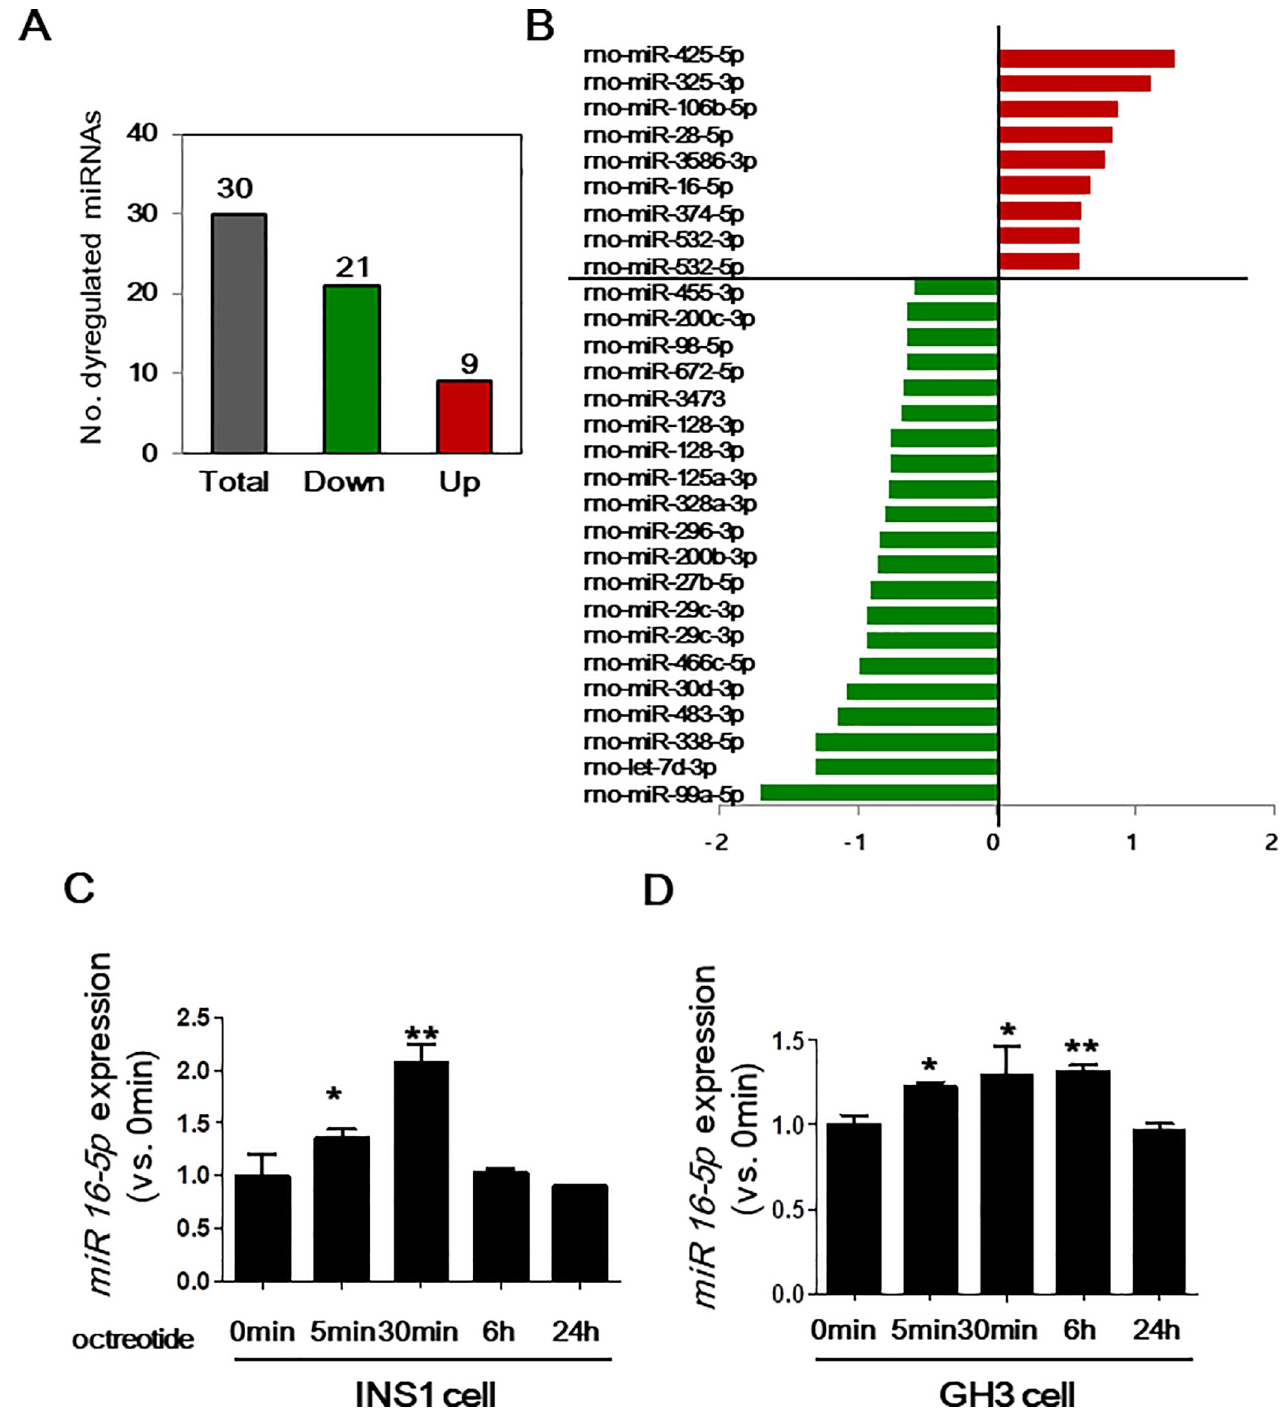
Fig 2. Microarray analysis of miRNA expression. miRNA profiling was performed to determine the (A) number and (B) profile of differentially expressed miRNAs. Red and green indicate significantly upregulated or downregulated miRNAs, respectively. INS-1 cells (C) and GH3 cells (D) were incubated with 1 μ mol/L octreotide. After the indicated incubation time, total RNA was isolated, after which miR-16-5p levels were measured by qRT-PCR and normalized for input RNA using control miRNA (U87) with the 2 − ΔΔ Ct method. Data represent the mean of three independent experiments ± SD; � p < 0.05, �� p < 0.01.